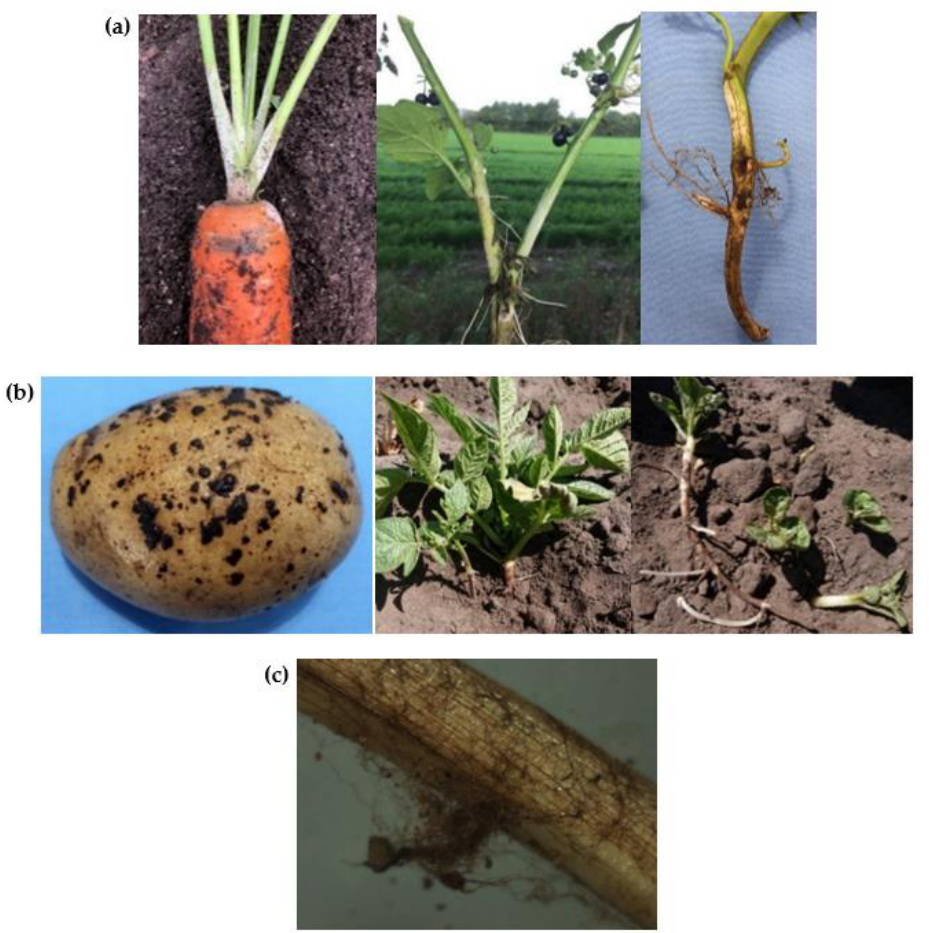
Figure 7. Different symptoms caused by Rhizoctonia solani AG 3. ( a ) Greyish-white felt-like mycelium symptoms on carrot (left), black nightshade (center) and potato (right); ( b ) Black scurf (left) and stem canker (center, right) on potato tubers and stolons; ( c ) Brown net of mycelium on carrot leaf stems.